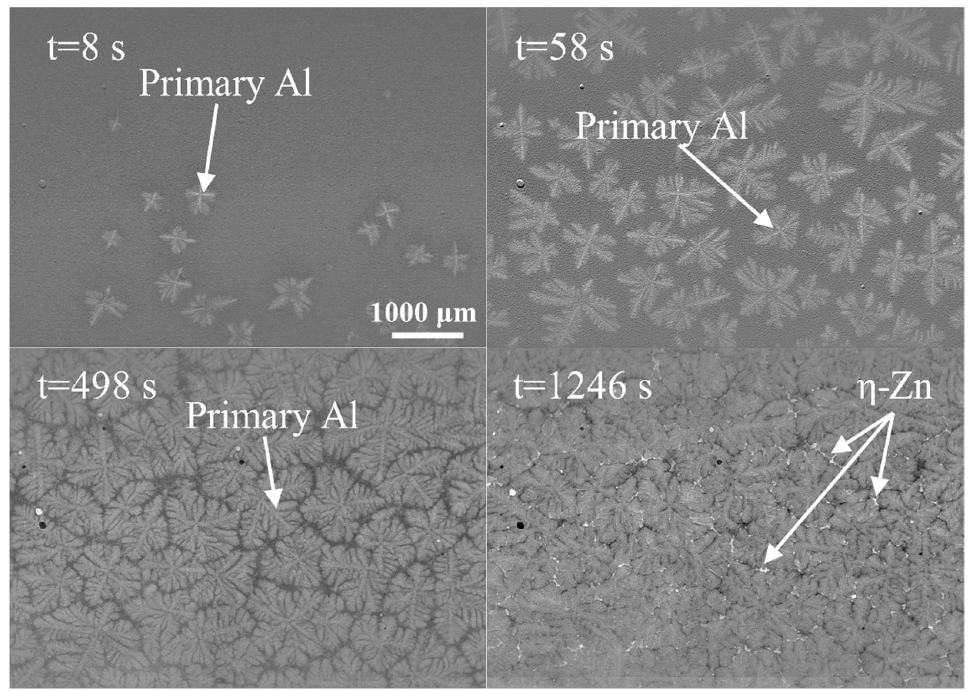
Figure 6. Synchrotron radiation images of Al-40Zn-3Si alloy during solidification at different times.